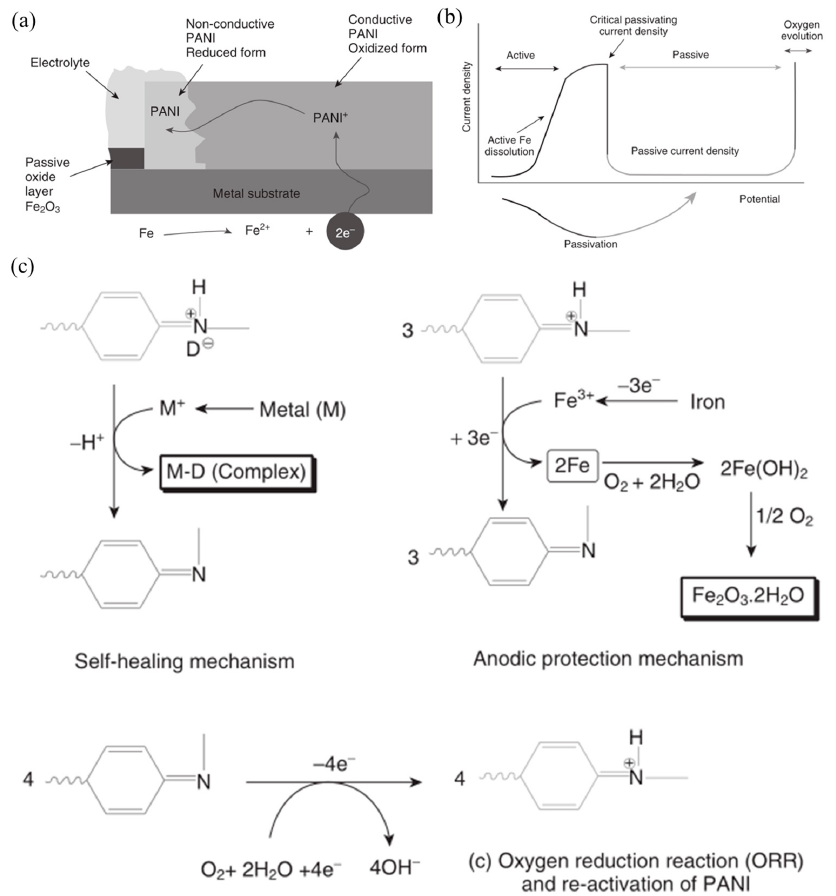
Figure 4. ( a ) The concept of ennobling mechanism using PANI. ( b ) Corrosion protection of iron electrode coated with conductive polymer. Two mechanisms can be identified: (1) barrier protection of the PANI coating suppresses the active metal dissolution, and (2) ennobling effect due to the redox activity of the PANI which shifts the potential into a passive domain at higher potential val- ues. ( c ) Schematic illustration for the chemical reactions of PANI for corrosion protection of iron through different mechanisms [87].